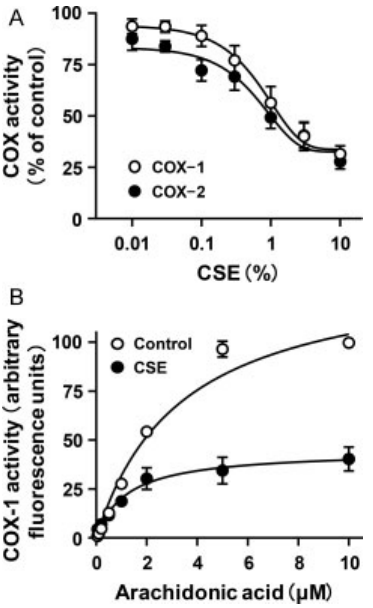
Fig. 4 Inhibitory effects of cigarette smoke extract (CSE) on COX-1 and COX-2 activities. ( A ) Arachidonic acid was added to a solution containing ovine COX-1 or human COX-2 and incubated for 2